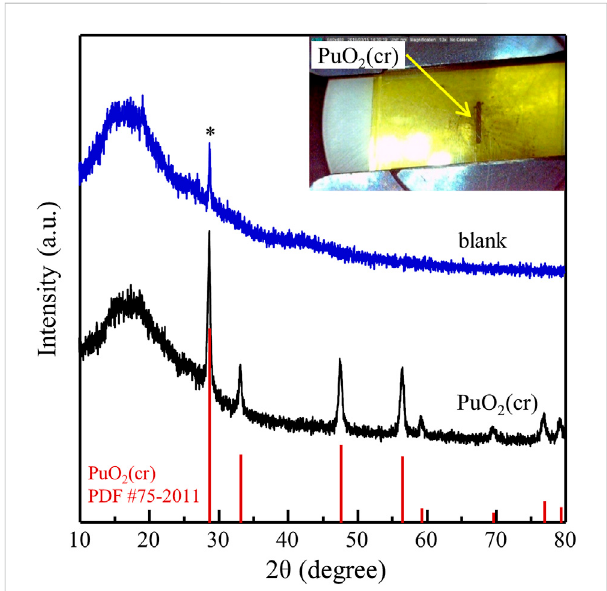
FIGURE 1 XRD spectrum of PuO 2 (cr) measured before solubility study. XRD spectrum of the blank sample without Pu is shown for